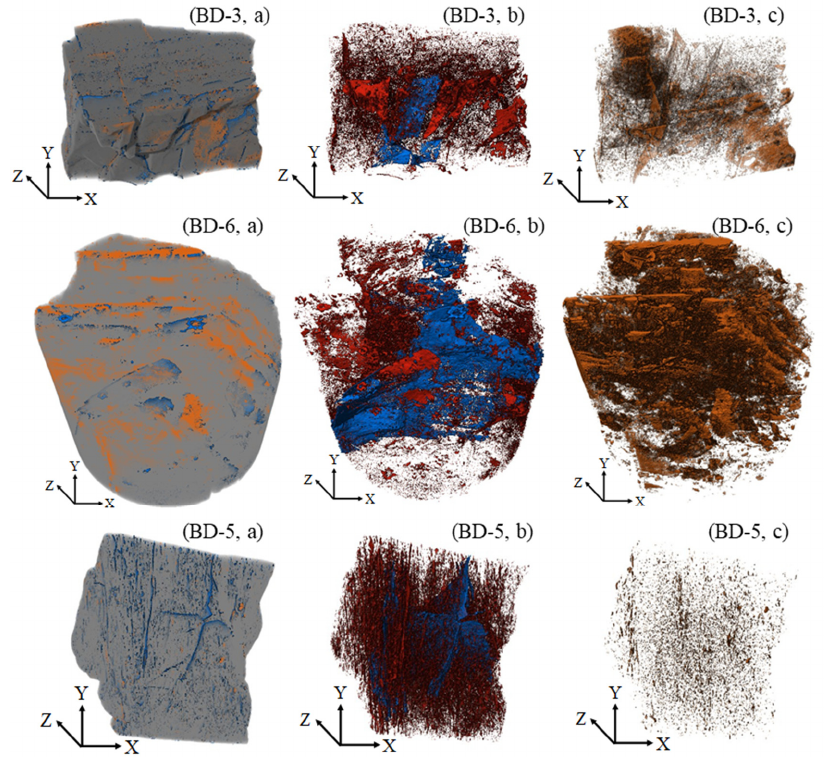
Figure 12. ( a ) Three-dimensional reconstruction image of coal samples (gray: matrix, blue: pores and fractures, orange: mineral). ( b ) Three-dimensional image of connected and isolated pores and fractures (blue: connected pores and fractures, red: isolated pores and fractures). ( c ) Three-dimensional image of minerals.